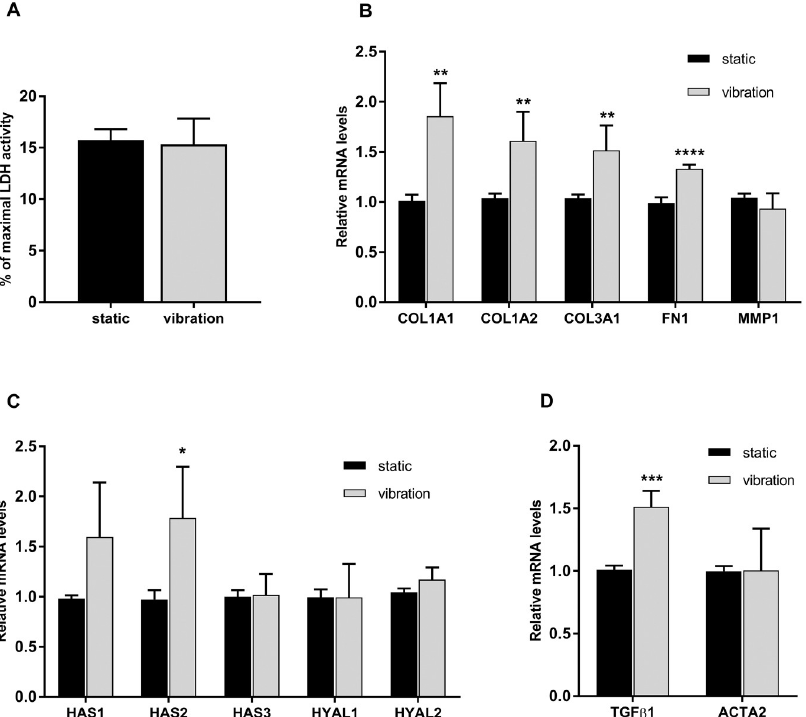
Fig 3. Effect of vibration on cell viability and gene expression. After 48 hours of exposure to a vibration pattern and a one-hour rest period, supernatants and cell lysates were collected for LDH activity assay (A) and RNA isolation, respectively. mRNA was reverse transcribed to cDNA, and RT-qPCR was performed. Relative gene expression (B, C, D) was calculated using the 2 - ΔΔ C T method. The values are mean ± SD of at least 3 experiments performed in quadruplicates and analysed by a Student’s t-test; � p < 0.05, �� p < 0.01, ��� p < 0.0001.